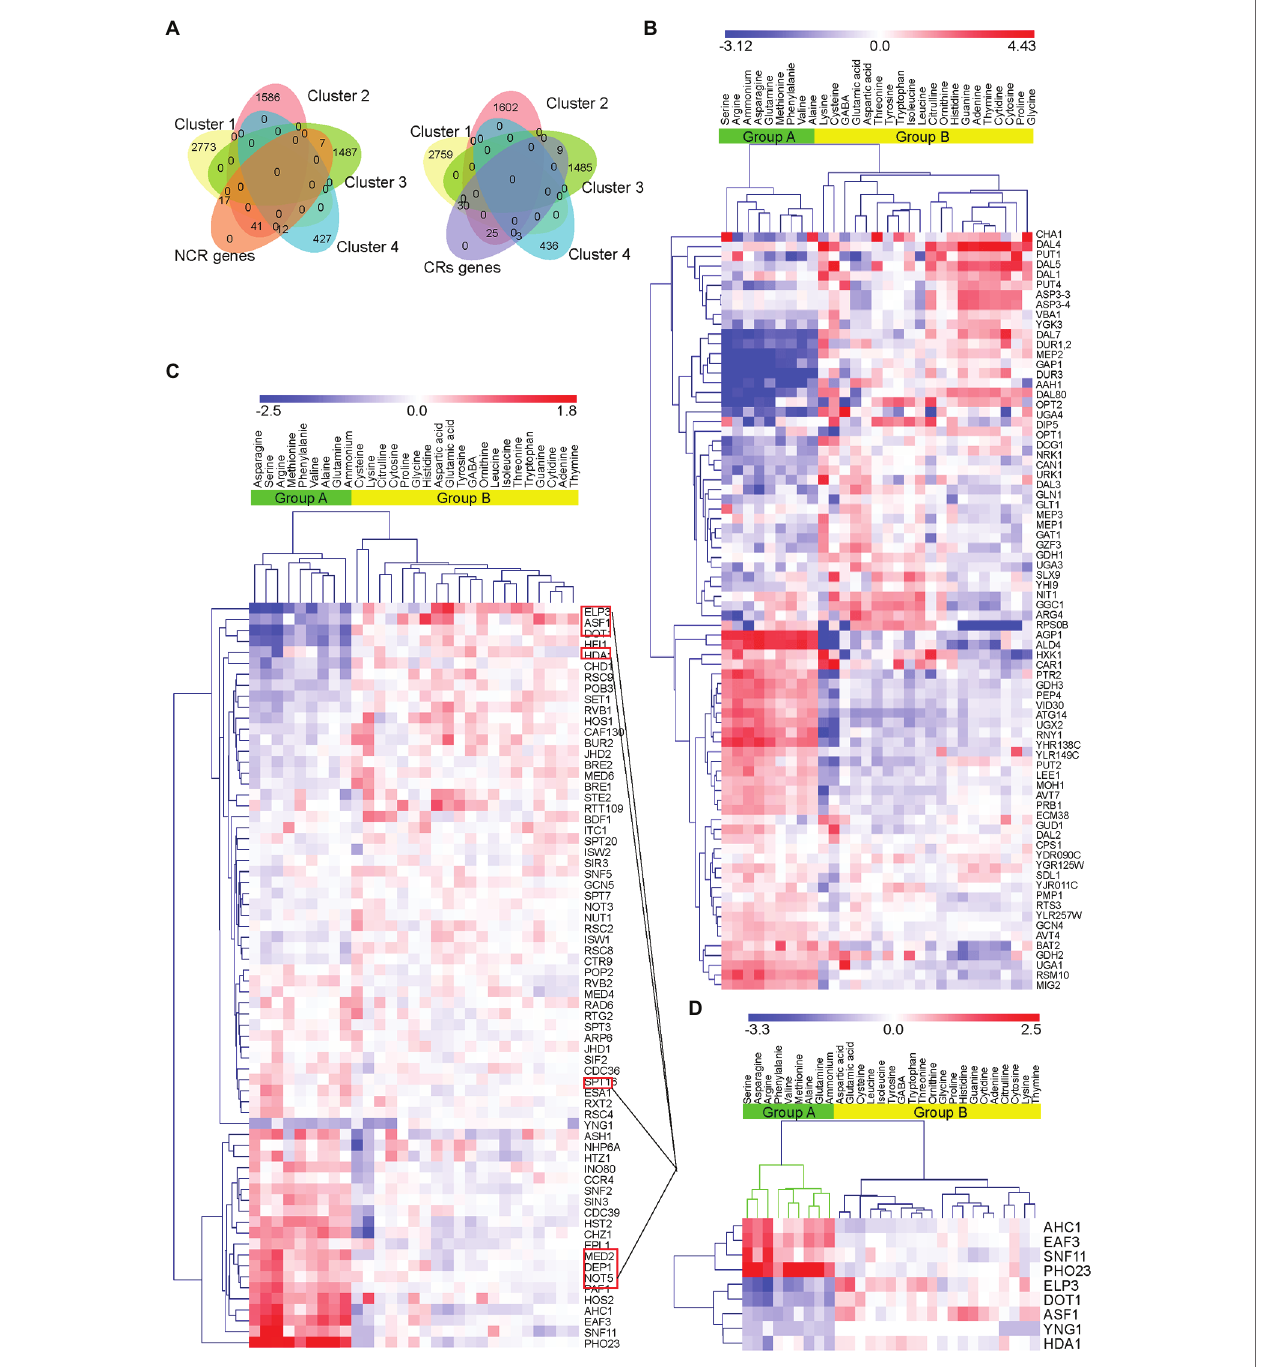
FIGURE 2 | Venn diagrams and heatmaps of NCR target genes and CRs enrichment. (A) Venn diagrams of NCR and CRs in the four clusters. A total of 78 NCR genes and 67 CRs were obtained from the four clusters. (B) Hierarchical clustering of 78 NCR genes in response to changes in nitrogen sources based on normalized log2FoldChange. The green cluster (Group A) represents the preferred nitrogen sources of S288C obtained by clustering. Downregulated genes are highlighted in blue and upregulated genes are highlighted in red. (C) Hierarchical clustering of 67 CRs in response to changes in nitrogen sources based on normalized log 2 foldchange. Group A (green) obtained by clustering is consistent with NCR genes. Red square frames indicate nine CRs showing significant changes in transcription in the presence of various nitrogen sources. (D) Enrichment heatmap of the nine CRs showing the most significant differences in transcription in response to nitrogen sources among 67